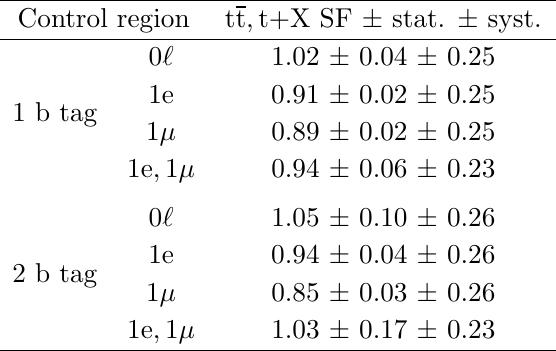
Table 1 . The scale factors (SF) derived to correct for the event yields of the tt and t+X backgrounds in simulation for di(cid:11)erent top quark control regions. The uncertainties arising from the limited size of the data samples (stat.) and systematic e(cid:11)ects (syst.), described in section 7, are